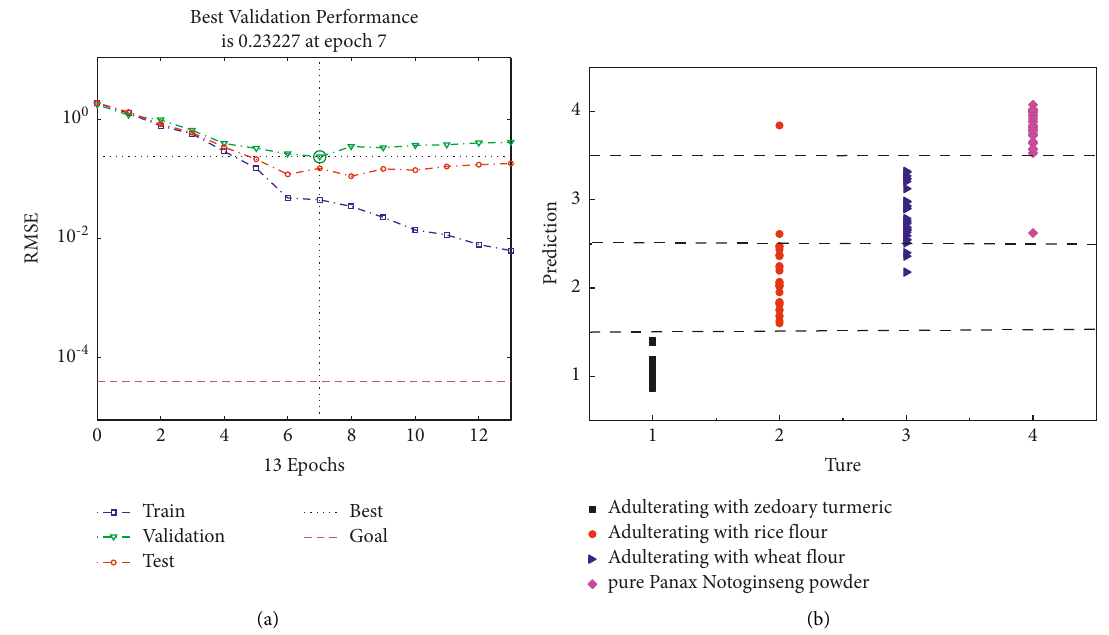
Figure 5: UVE-BPNN model results, (a) BPNN training process; (b) scatter diagram of BPNN prediction model.